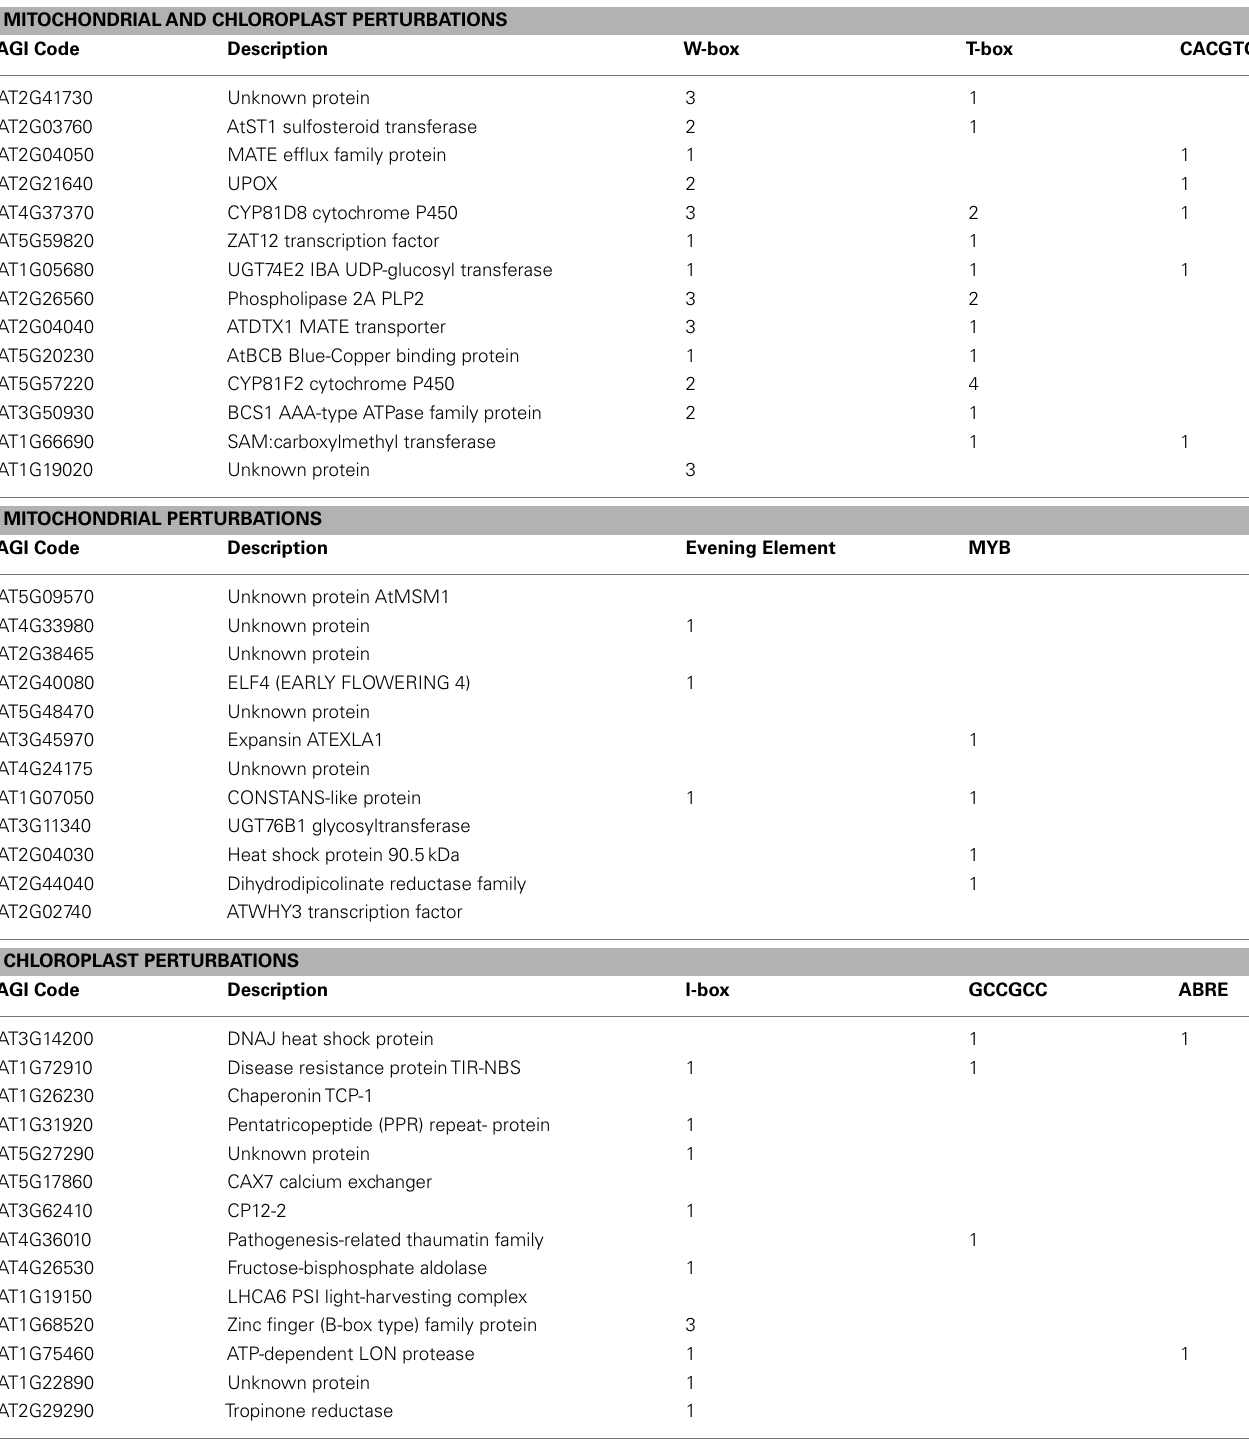
Table 5 | Occurrence of known transcription factor binding sites in marker